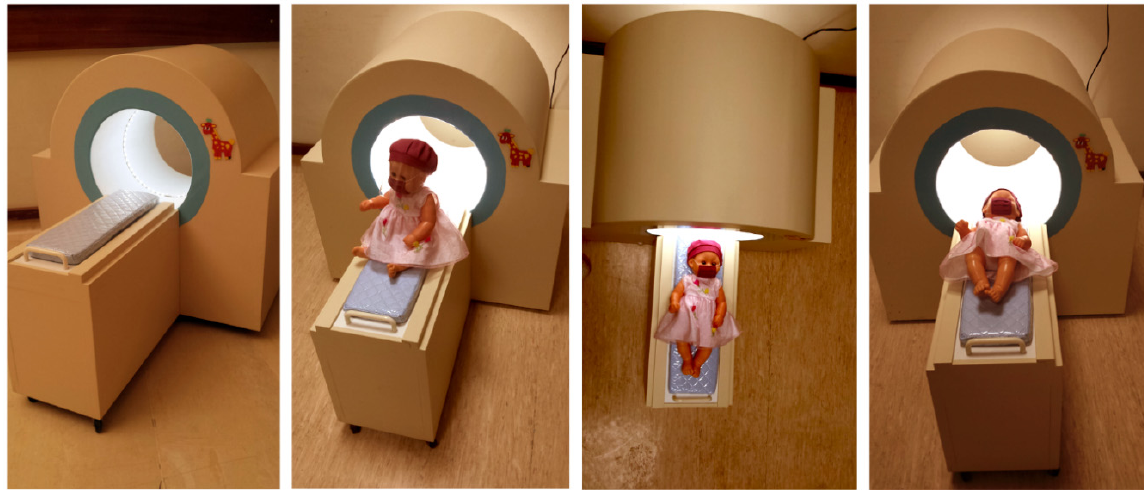
Figure 2. Mini-resonance toy imitating the looks and sounds of a real MR, built for this